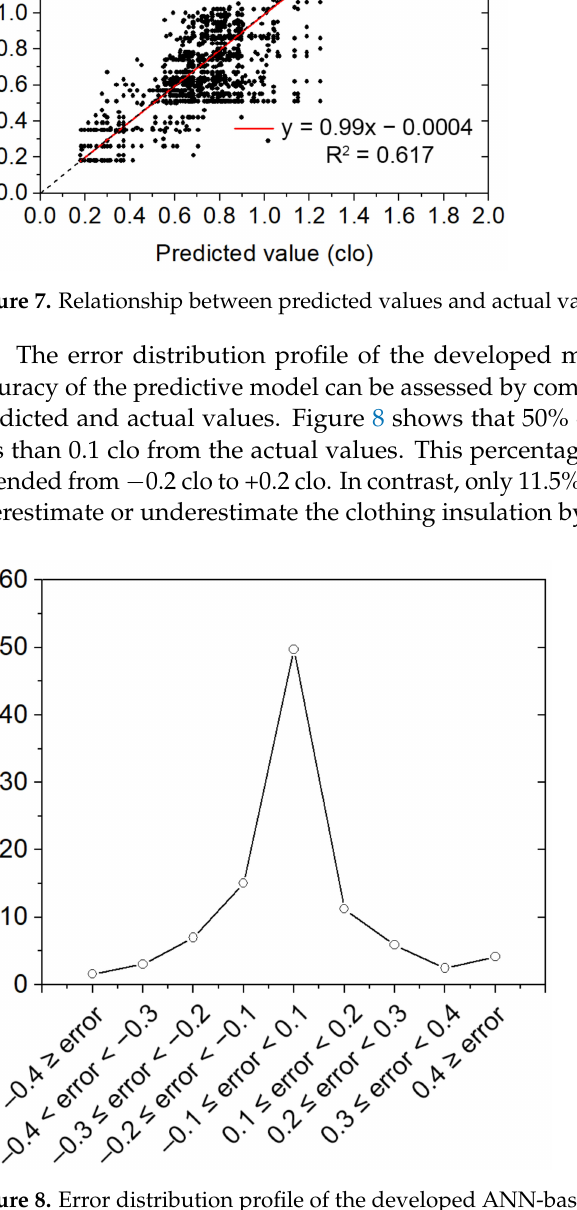
Figure 8. Error distribution profile of the developed ANN-based